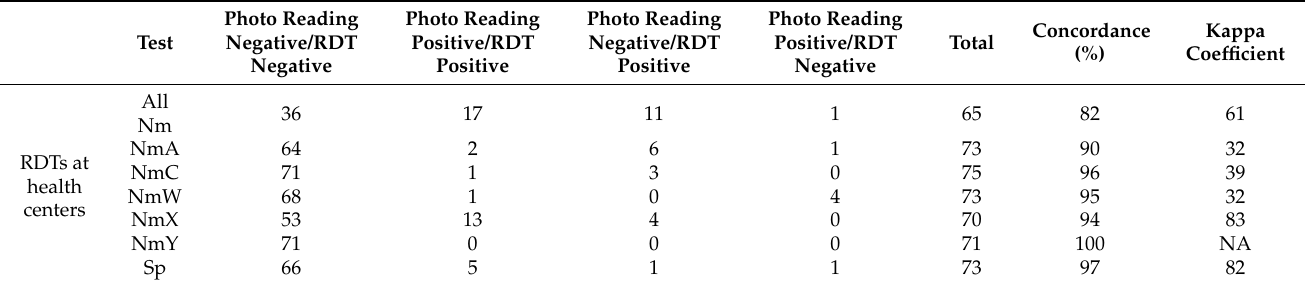
Table 5. Concordance of the results of RDTs as interpreted live in the PHCs and by independent reading of photographs, Burkina Faso and Niger,